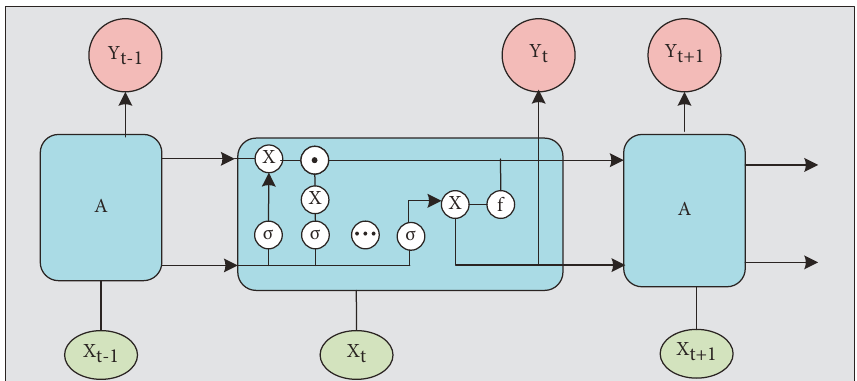
Figure 2: Structural model of long-short-term memory neural